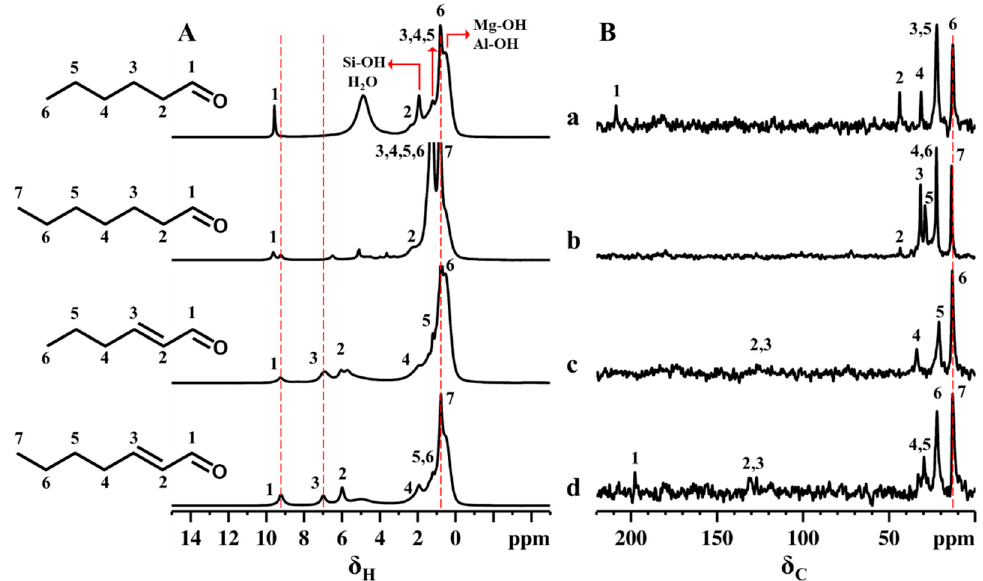
Figure 4. 1 H ECHO ( A ) and 13 C CPMAS ( B ) NMR spectra of SapC6AN (a), SapC7AN (b), SapC6EN (c) and SapC7EN (d) samples.